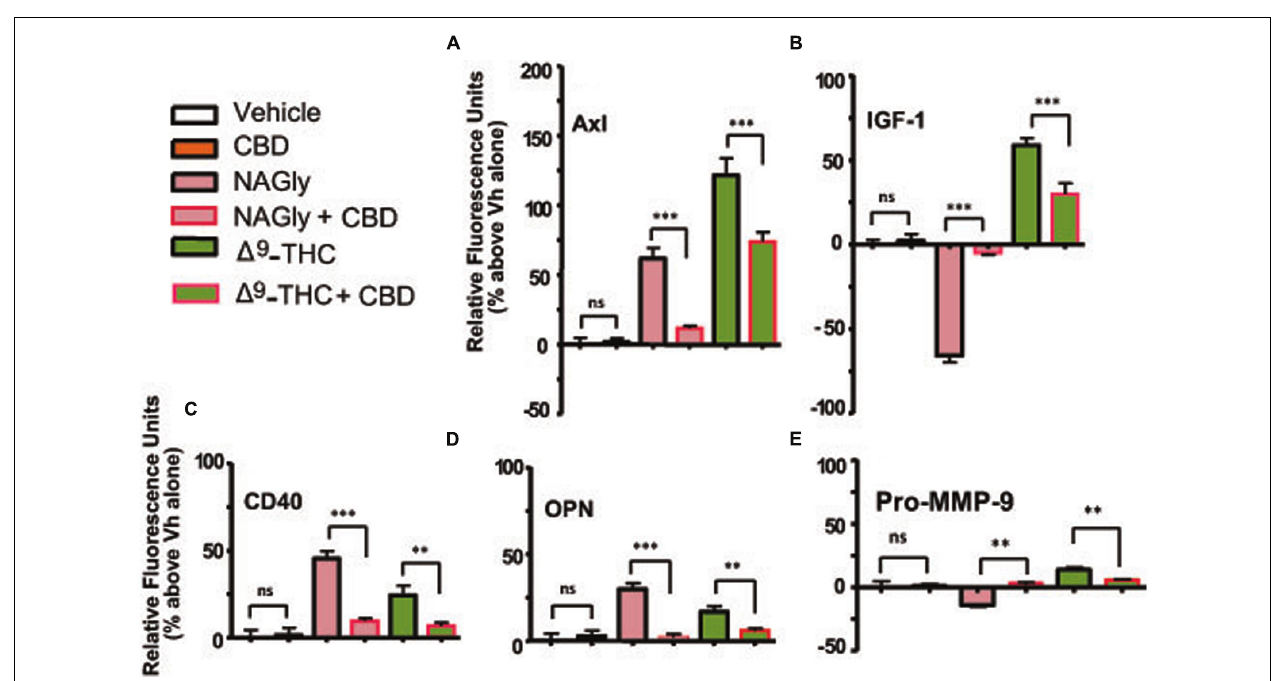
FIGURE 4 | Levels of cytokine production after 3 h treatment co-incubation with CBD in BV-2 microglia. (A) Axl, (B) IGF-1, (C) CD40, (D) OPN, (E) Pro-MMP-9. Cytokine production by BV-2 microglia in response to NAGly (10 nM) and (cid:2) 9 -THC (100 nM) ± CBD (100 nM) n = 4–5. ** p < 0.01, *** p < 0.001 (One-way